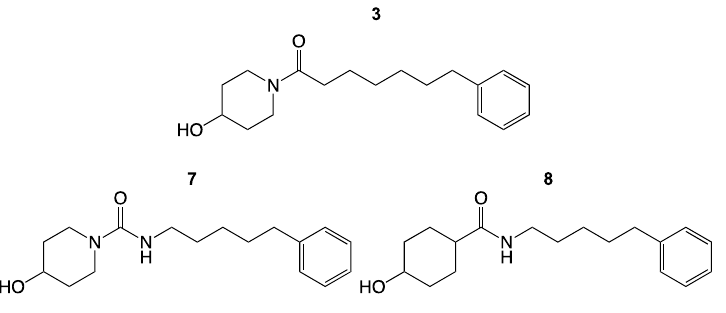
Figure 6. Amide variants of compound 3 . Table 3. Functional and pharmacokinetic properties of amide variants of 3 . Values for 3 are duplicated from Table 2 for comparison.